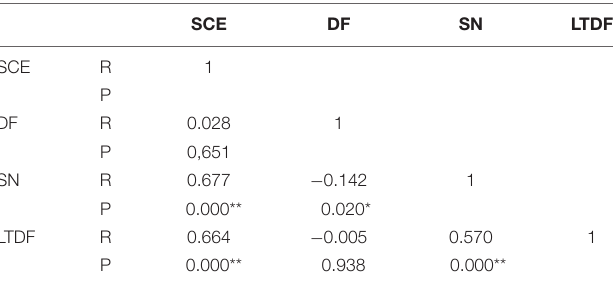
TABLE 4 | Pearson Moment Correlation results for TDEQ facets.